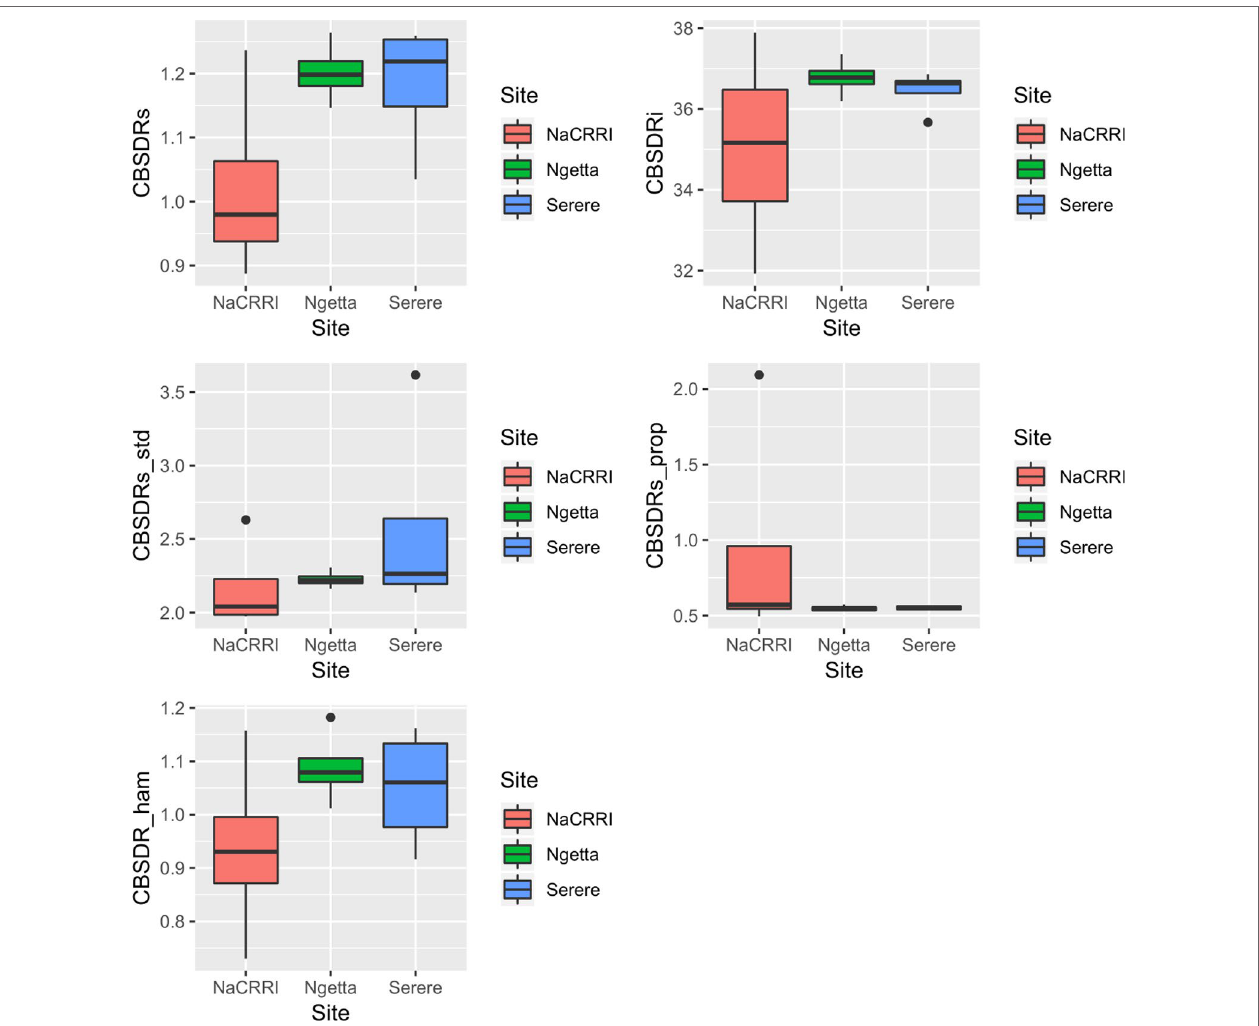
FiGURe 2 | Standard errors associated with CBSD root necrosis assessment traits across three sites: Namulonge (central Uganda), Ngetta (northern Uganda) and Serere (eastern Uganda). CBSDRi cassava brown streak disease root incidence; CBSDRs, cassava brown streak disease root severity; CBSD-Harmonic, cassava brown streak disease root severity computed as harmonic mean; CBSD-proportion, proportion-based root necrosis index; CBSD-standardized, standardized root necrosis index.